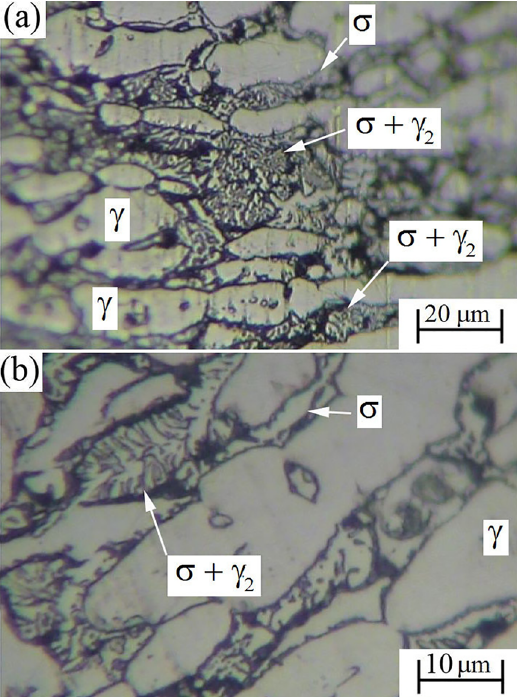
Figure 9. Microstructures obtained after portable DL-EPR test performed at room temperature in SD-A material aged at 850ºC for 45 minutes.